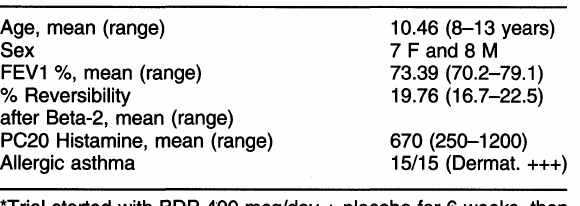
FIG. 1. BDP vs. nedocromil. A FEV1 (mean change from baseline) in the and groups treated.